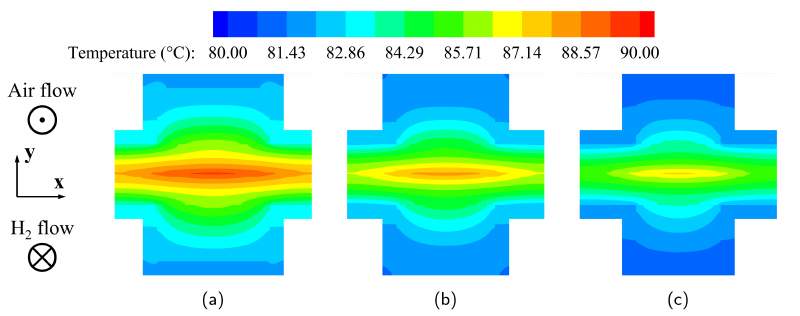
Figure 13. Impact of the LCWR on the temperature distribution over the middle plane of the PEMFCs in the z direction: ( a ) LCWR = 0.75. ( b ) LCWR = 1. ( c ) LCWR =